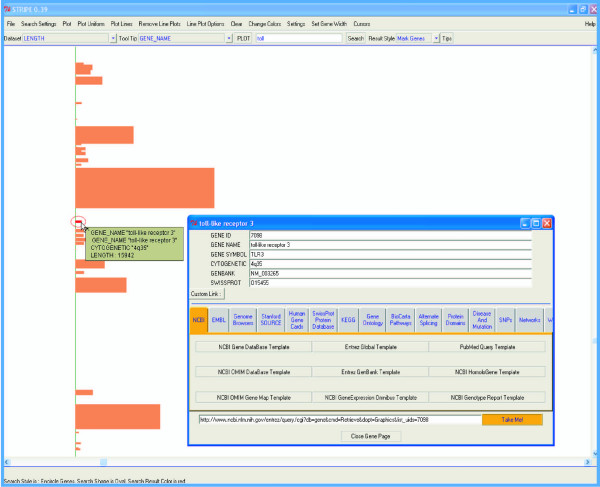
A zoomed in view of a search result for the keyword "toll" is shown here. Search results are shown encircled by a oval, and are colored in red. Both the color of the matching results, and how the result is encircled (oval, circle or rectangle) can be customized before searching, allowing several searches to be performed on the same plot. Also shown is the gene page window which provides well-organized access to the several information resources for each gene.